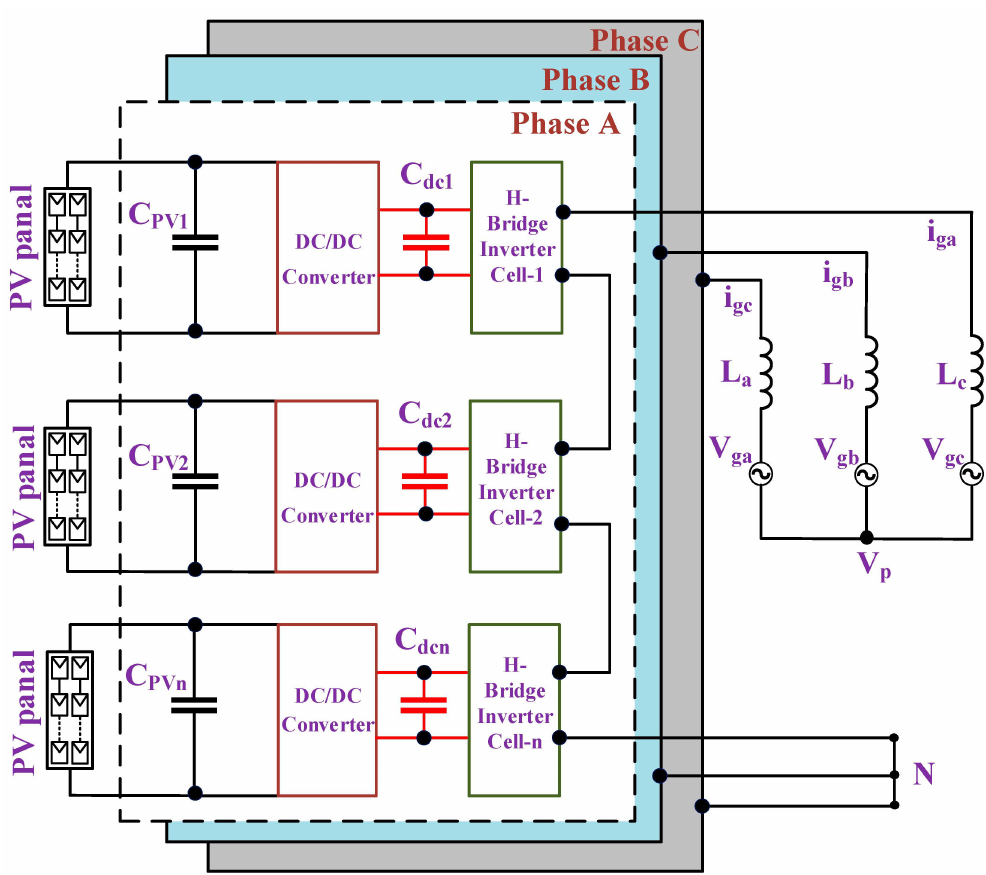
Figure 9. A CHB MMI with DC converters [59].